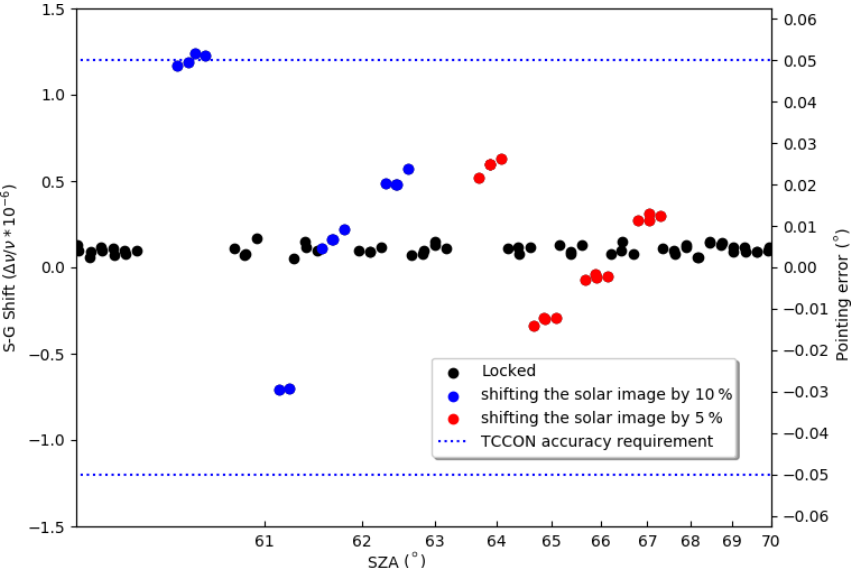
Figure 11. Intentional mispointing tests in four quadrants (L, R, U, D) by 10% (blue) and 5% (red) of the solar image diameter. Tests performed on 1 May 2020 using Lauder